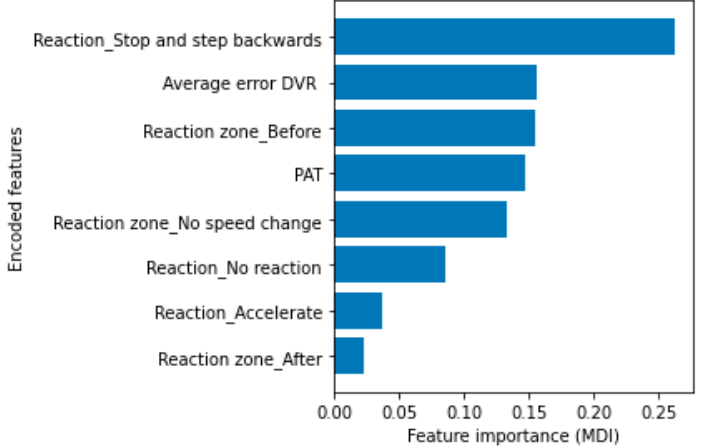
Figure 16. Random Forest feature importance using MDI criterion.